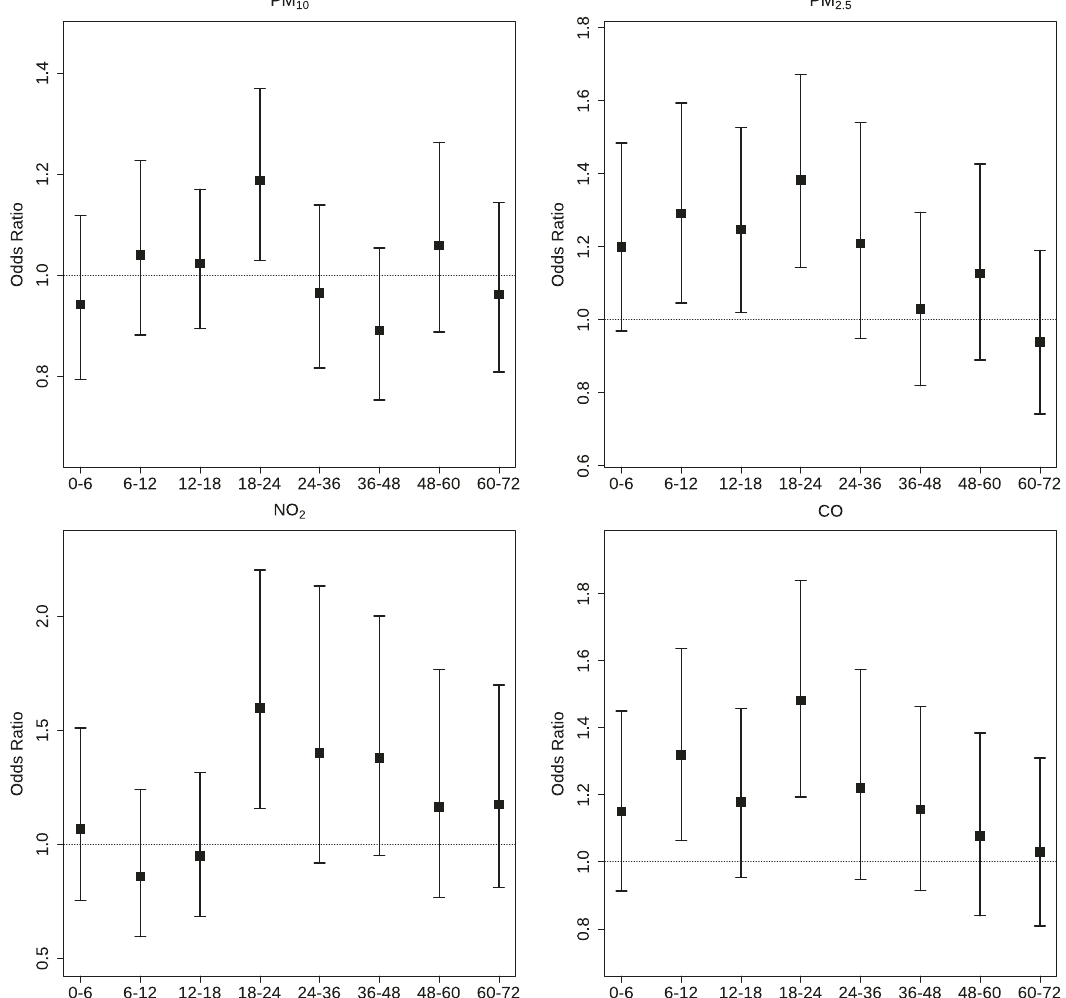
Fig. 1 Odds ratios of atrial fi brillation associated with an interquartile range increase in air pollutant concentrations on different lag intervals. Abbreviations and interquartile range concentrations as in Table 2. Lags hours, e.g., Lag 0 – 6, the moving average concentrations of the current to the previous 6 h; Lag 6 – 12, the moving average concentrations of the previous 7 to the previous 12 h. Error bars are de fi ned as standard deviation